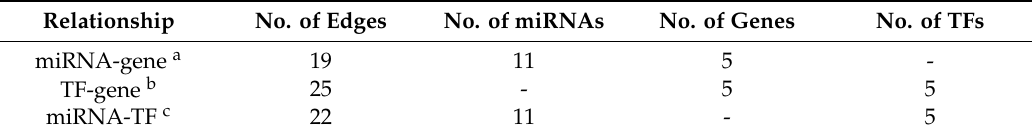
Table 2. Summary of regulatory relationships between NSCLC-associated DEGs, miRNAs, and TFs. Relationship No. of Edges No. of miRNAs No. of Genes No. of TFs miRNA-gene a 19 11 5 - TF-gene b 25 - 5 5 miRNA-TF c 22 11 -